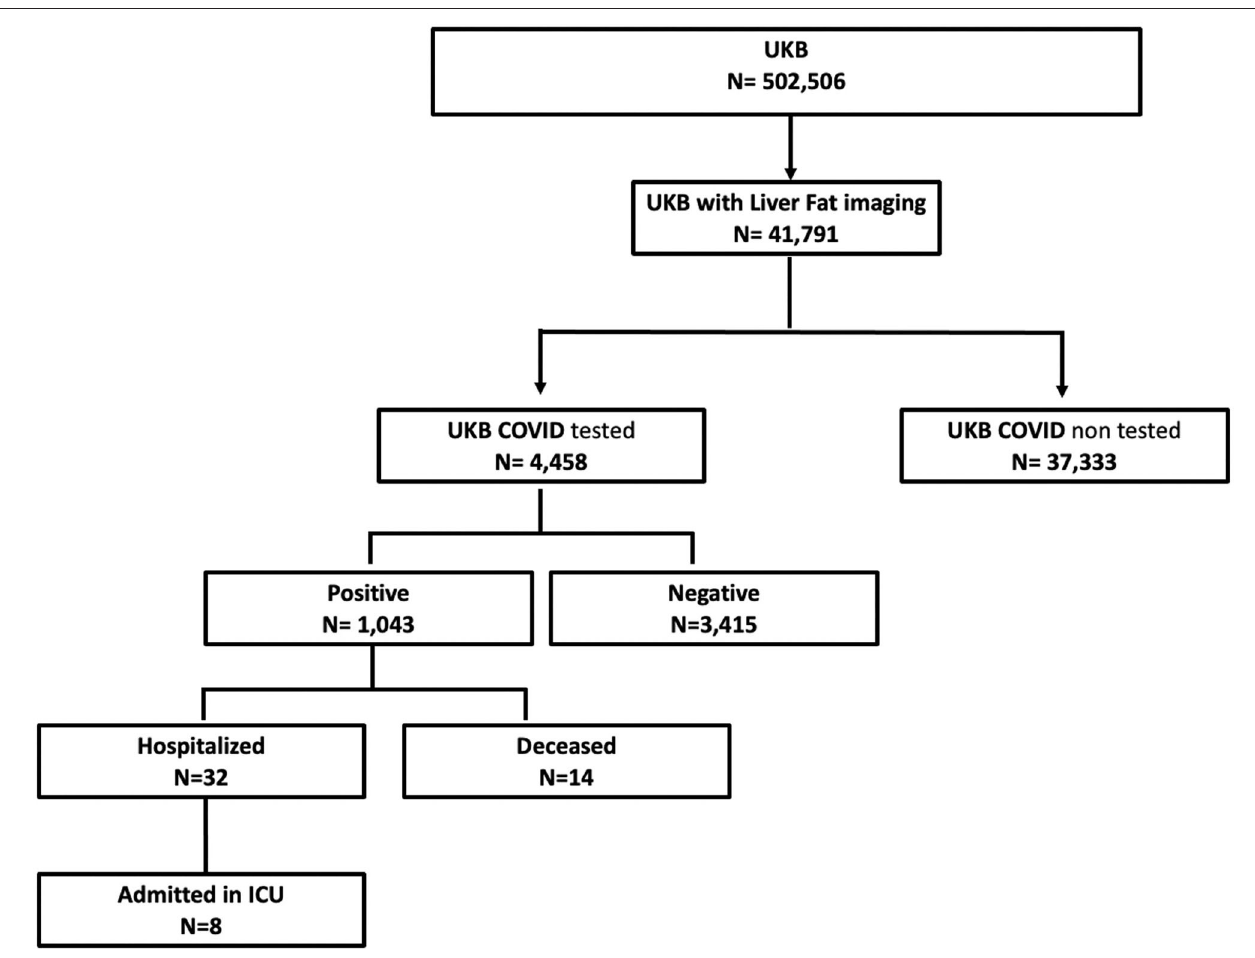
FIGURE 1 | Summary of UKB data